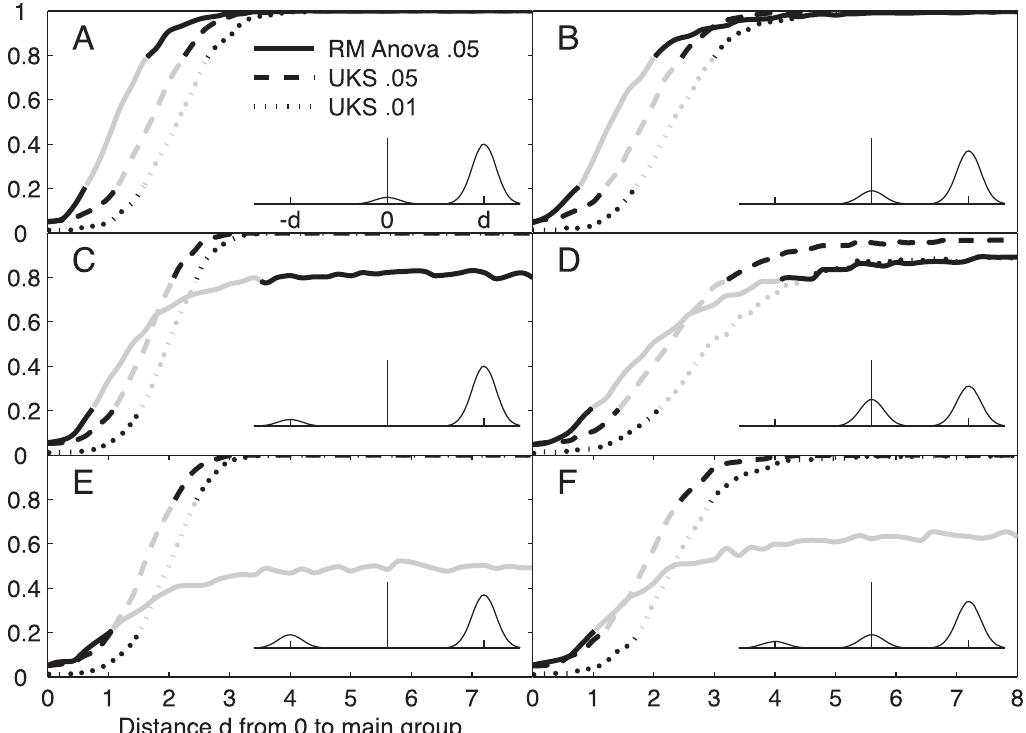
Figure 2. Type II errors and reproducibility with heterogeneous experimental effects . Each panel displays the proportion of significant hypothetical experiments as a function of the difference d between the constant values of experimental effect in 2 (panels A–E) or 3 sub-populations (panel F). The lines show the proportion of significant tests in 10000 hypothetical experiments for 41 values of d from 0 to 8 by .2 steps for RM Anovas (continuous line) and the UKS test at both the .05 (dashed line) and.01 threshold (dotted line). The gray part of lines indicates the 0.211–0.789 range of proportion of significant tests for which the probability that two subsequent experiments yield conflicting outcomes exceeds 1/3. Each experiment consists in 10 individuals performing 8 trials in a baseline condition and in an experimental condition. Trial errors are drawn from a Gaussian distribution with parameters 0 and ! 8, so that the average of the experimental condition has a Gaussian distribution centered on – d , 0 or + d (Insets) with unitary variance. The proportion and center of the subpopulations varied across studies. In the first study ( panel A ), the experimental effect was set to 0 for 10% of the population, and to d for the remaining 90%. In the other studies ( Panels B–F ), the effects and proportions were as follows: [0, 20%; d , 80%]; – d , 10%; d , 90%]; [0, 40%; d , 60%]; – d , 20%; d , 80%]; [– d , 10%; 0; 20%; d , 70%]. For each hypothetical experiment, the 10 individual effects were drawn with replacement from a set of – d , 0 and + d values in the above proportions (for d =0, the proportion of significant tests is equal to the nominal type I error rate). We conclude that when factor effects vary across individuals as modeled by a mixture of Gaussians, UKS tests yield more reproducible outcomes than RM Anovas and have lower type II errors.